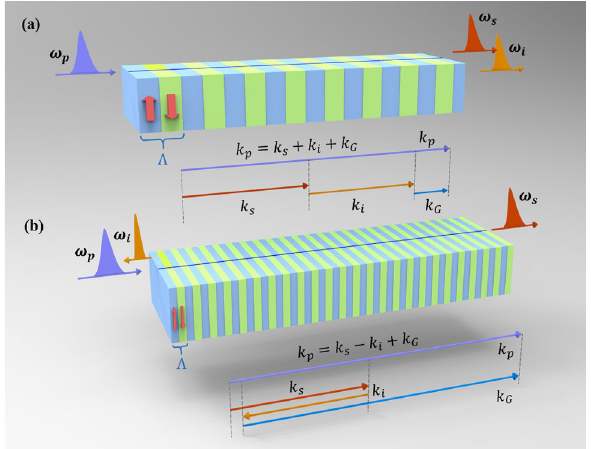
Figure 1. Sketches of photon pair generation and vector diagrams of QPM SPDC processes via conventional co-propagating phase matching ( a ), counter-propagating phase-matching ( b ). Green and blue areas on the 2 ) 2 ) crystal are inverted ( − χ ( ) and background positive ( + χ ( ) domains, respectively, with a period of (cid:31) . The purple, red, and oranges arrows represent pump ( k p ), signal ( k s ), and idler ( k i ) wave vectors, respectively, with the reciprocal wave vector k G denoted by the blue